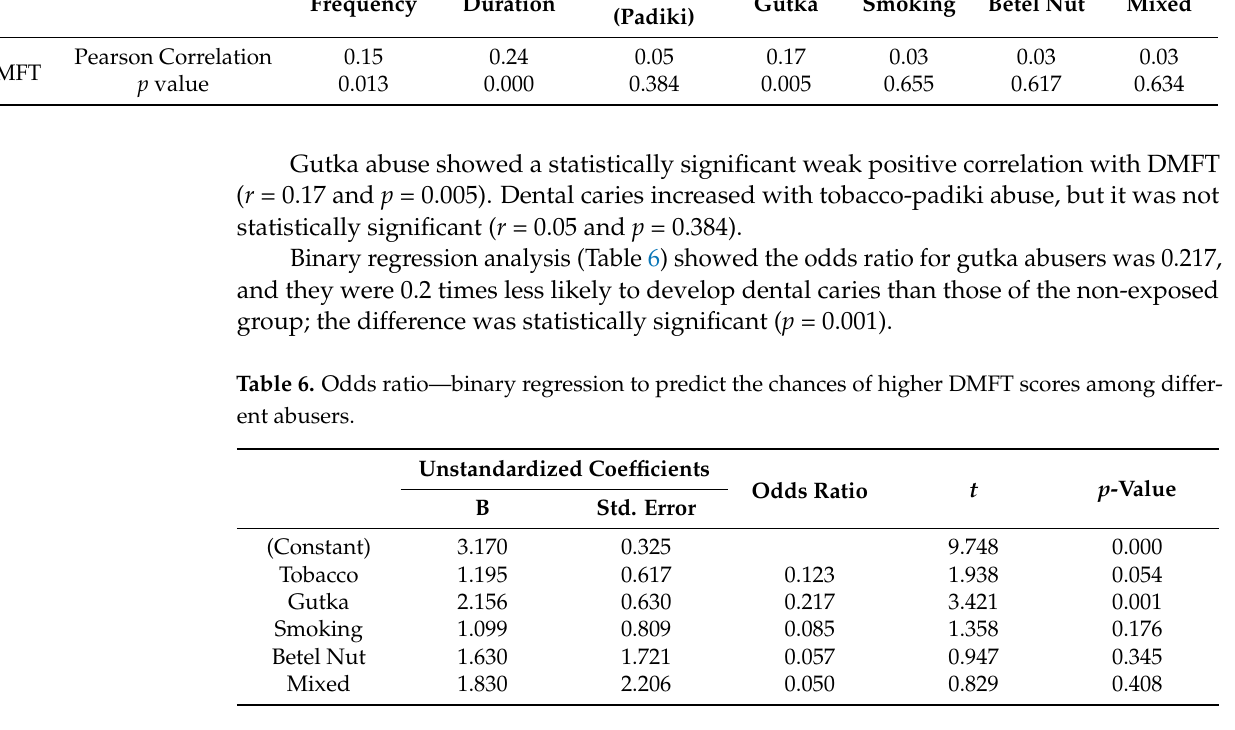
Tobacco Gutka (Padiki)